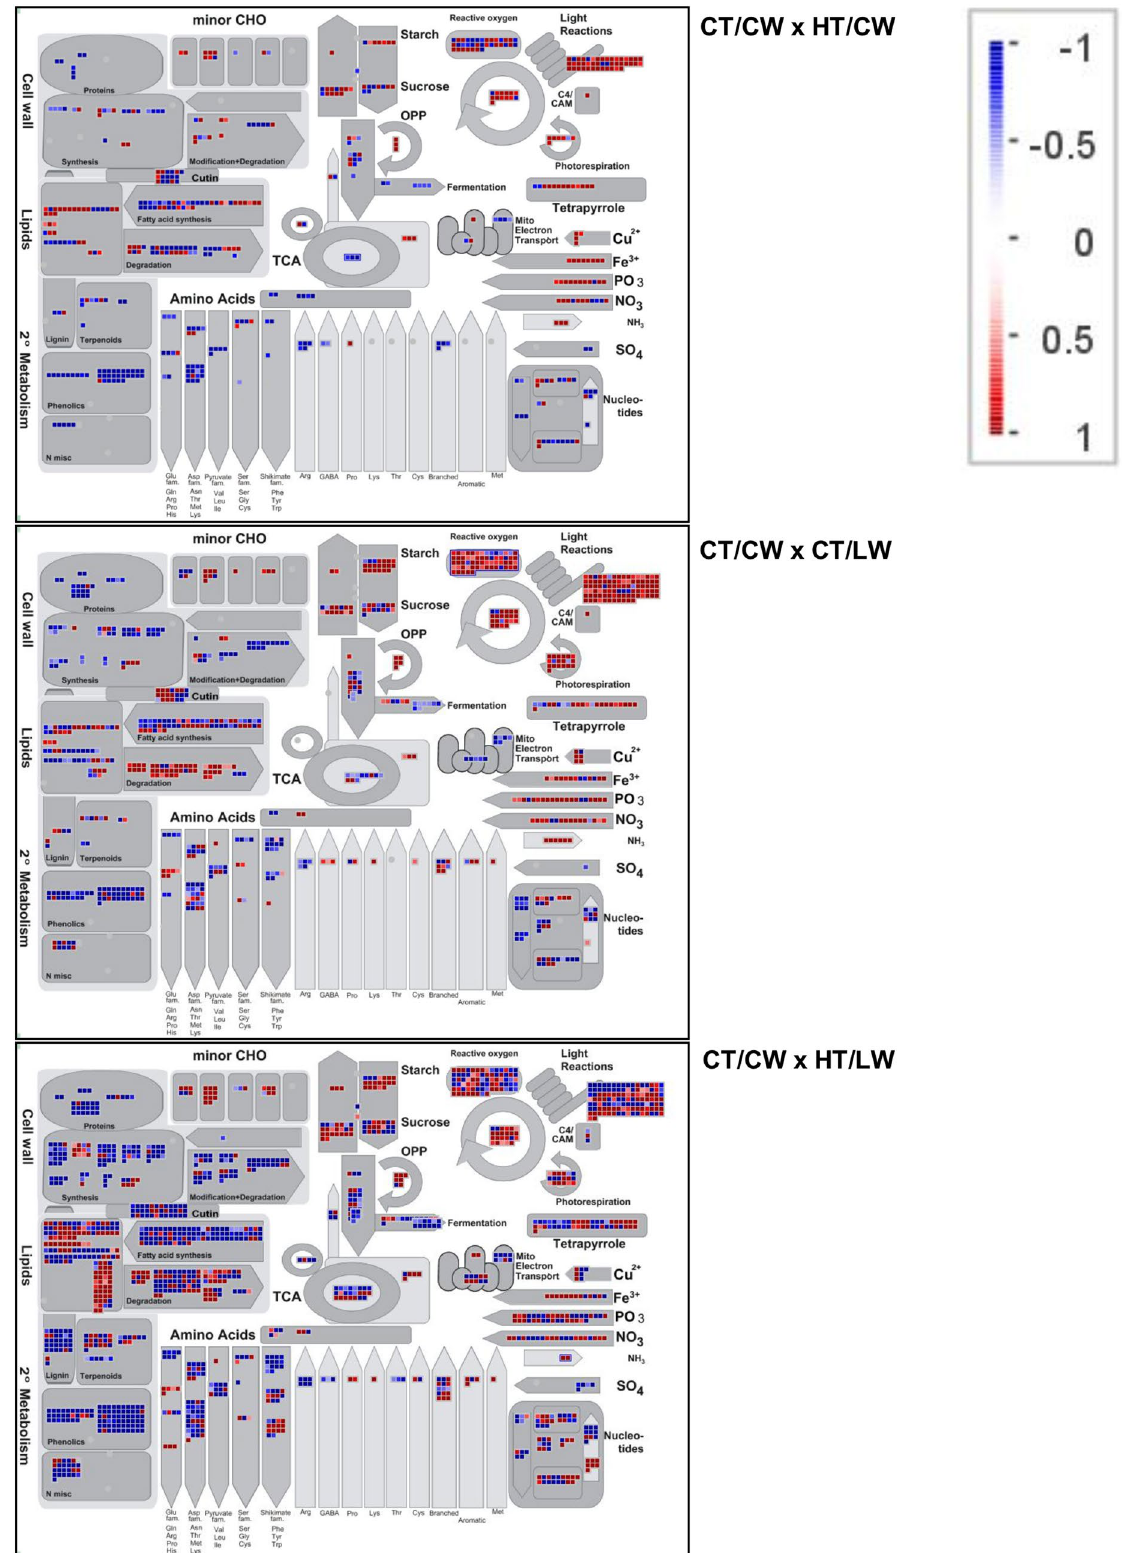
Figure 6. An overview map of primary metabolism pathways in leaf tissue affected by HT stress (HT/CW), LW stress (CT/LW), and the compound stress of HT and LW (HT/LW) compared to controls (CT/CW). Boxes represent a transcript annotated within each pathway, and color represents the relative degree of log2-fold change in comparison to control